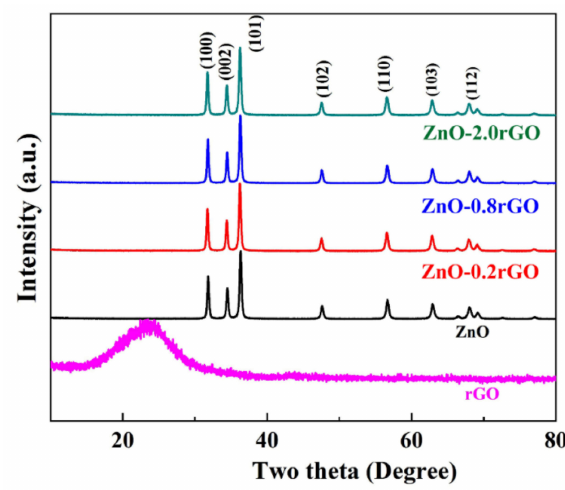
Figure 1. XRD patterns of rGO, ZnO, ZnO-0.2 rGO, ZnO-0.8 rGO, ZnO-2.0